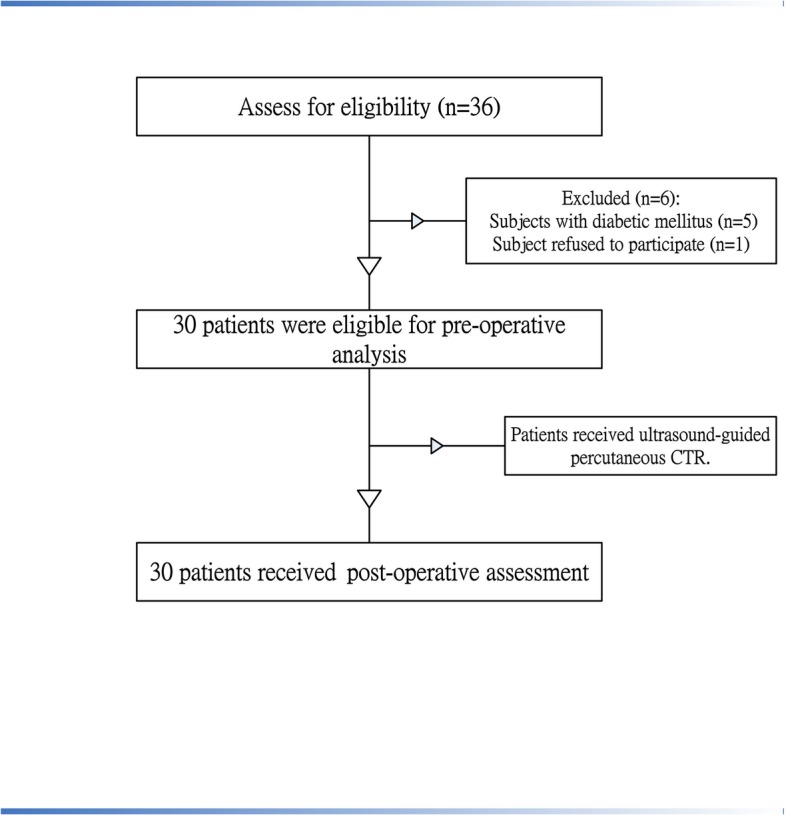
Flow chart shows enrollment of patients and completion of study.